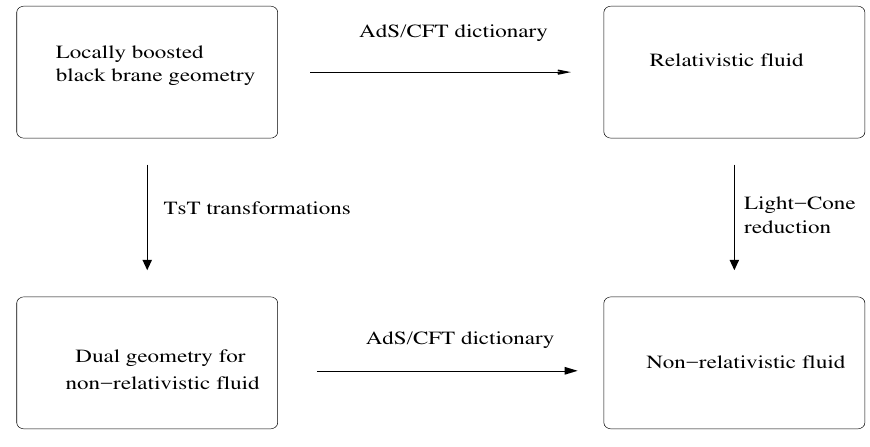
Figure 1 . Light-cone reduction vs. TsT